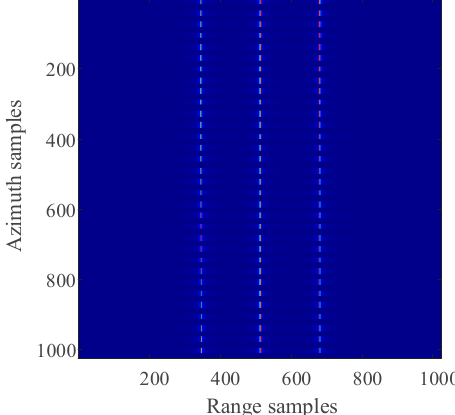
Figure 11. The result of range compression (time domain).